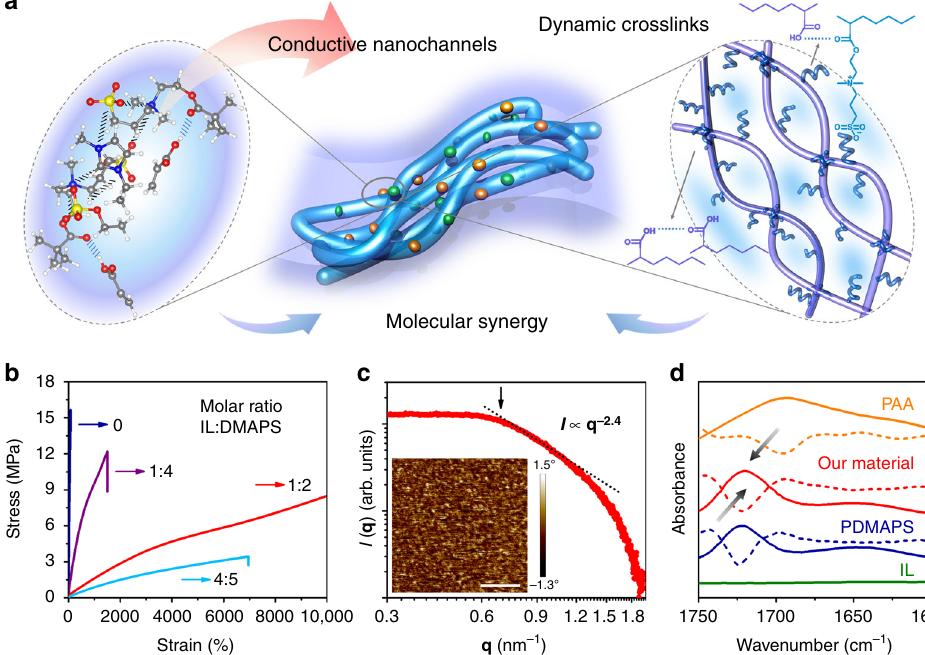
Fig. 1 Molecular synergistic design. a Schematic illustration of the molecular synergistic design, including the optimized ion-rich structure predicted by DFT and the dynamic hydrogen-bond networks. b The true tensile stress – strain curves of the conductors with different contents of the IL. The strain rate is 0.17 s − 1 . c The SAXS pro fi le of the intrinsically stretchable conductor. The inset picture is the AFM phase image of the conductor. (scale bar: 100 nm) d IR spectra and corresponding second derivative curves of the intrinsically stretchable conductor, PAA, PDMAPS, and IL in the region of 1750 – 1600 cm −